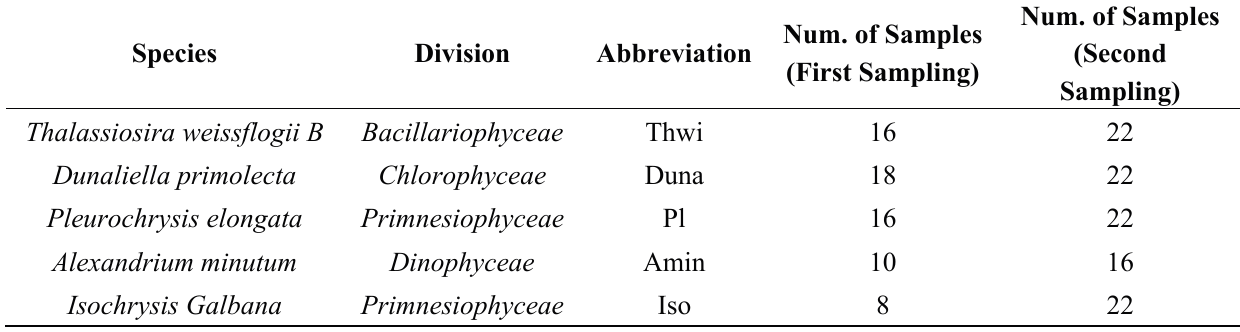
Table 2. Taxonomic groups of the five